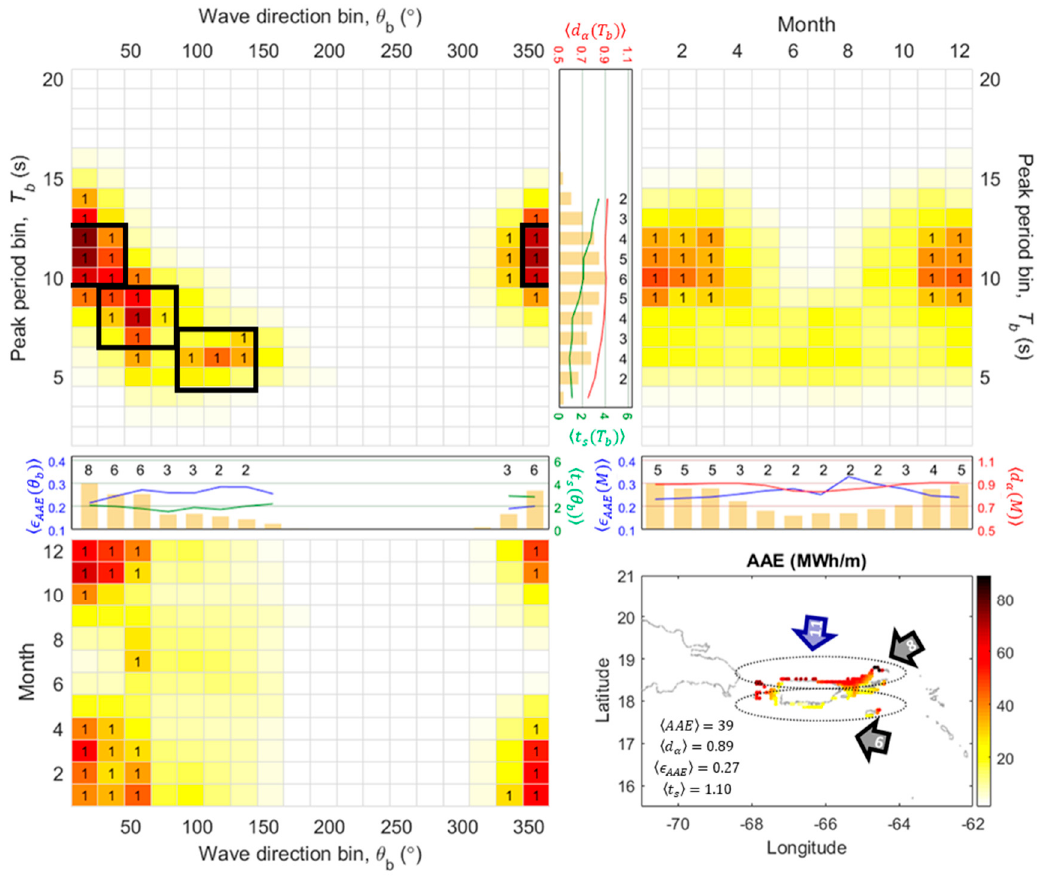
Figure 12. [Region 11: Puerto Rico] The detailed descriptions are identical to Figure